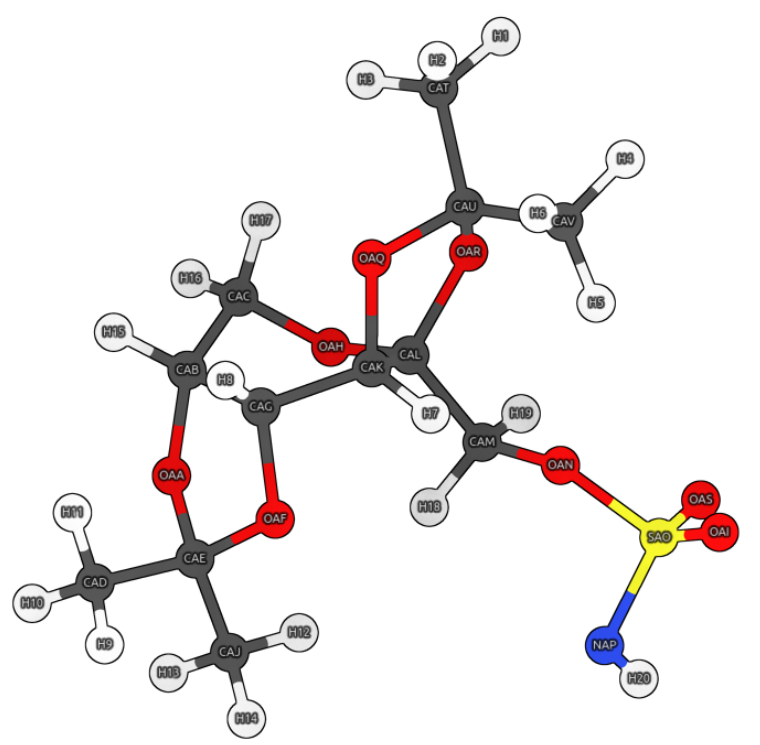
Figure 5. Graphical representation of the Topiramate (TPM) molecule and its atom designations. Color coding: white—hydrogen, grey—carbon, red—oxygen, blue—nitrogen, and